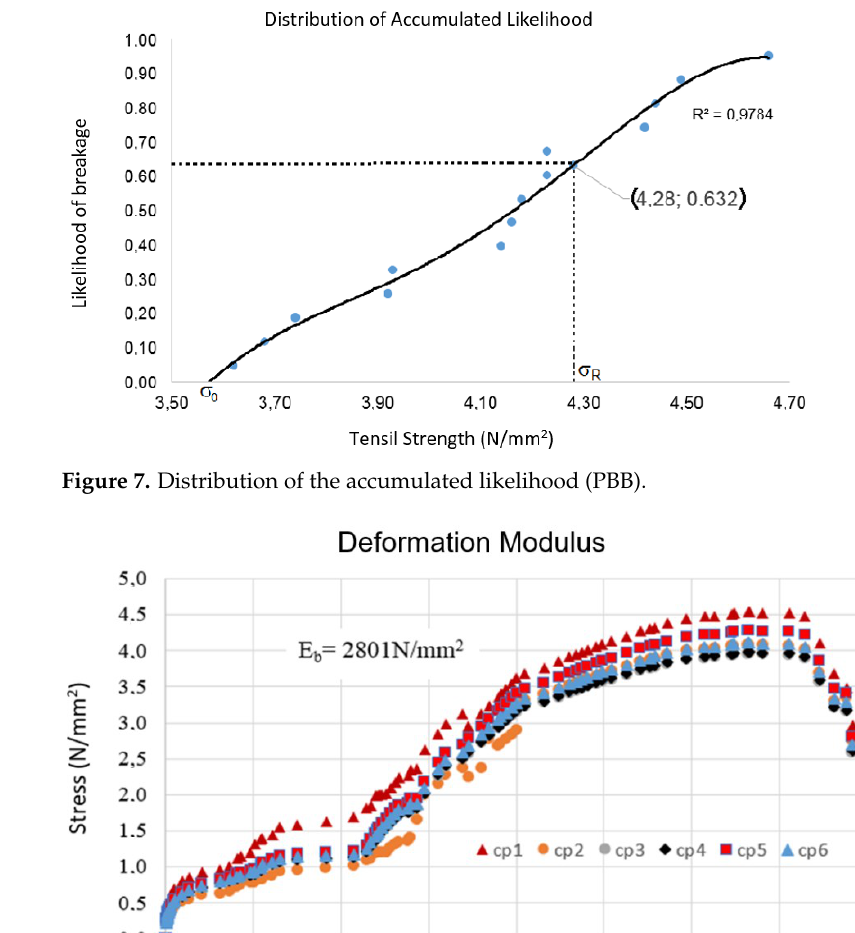
Figure 8. Strain curves-PBB.